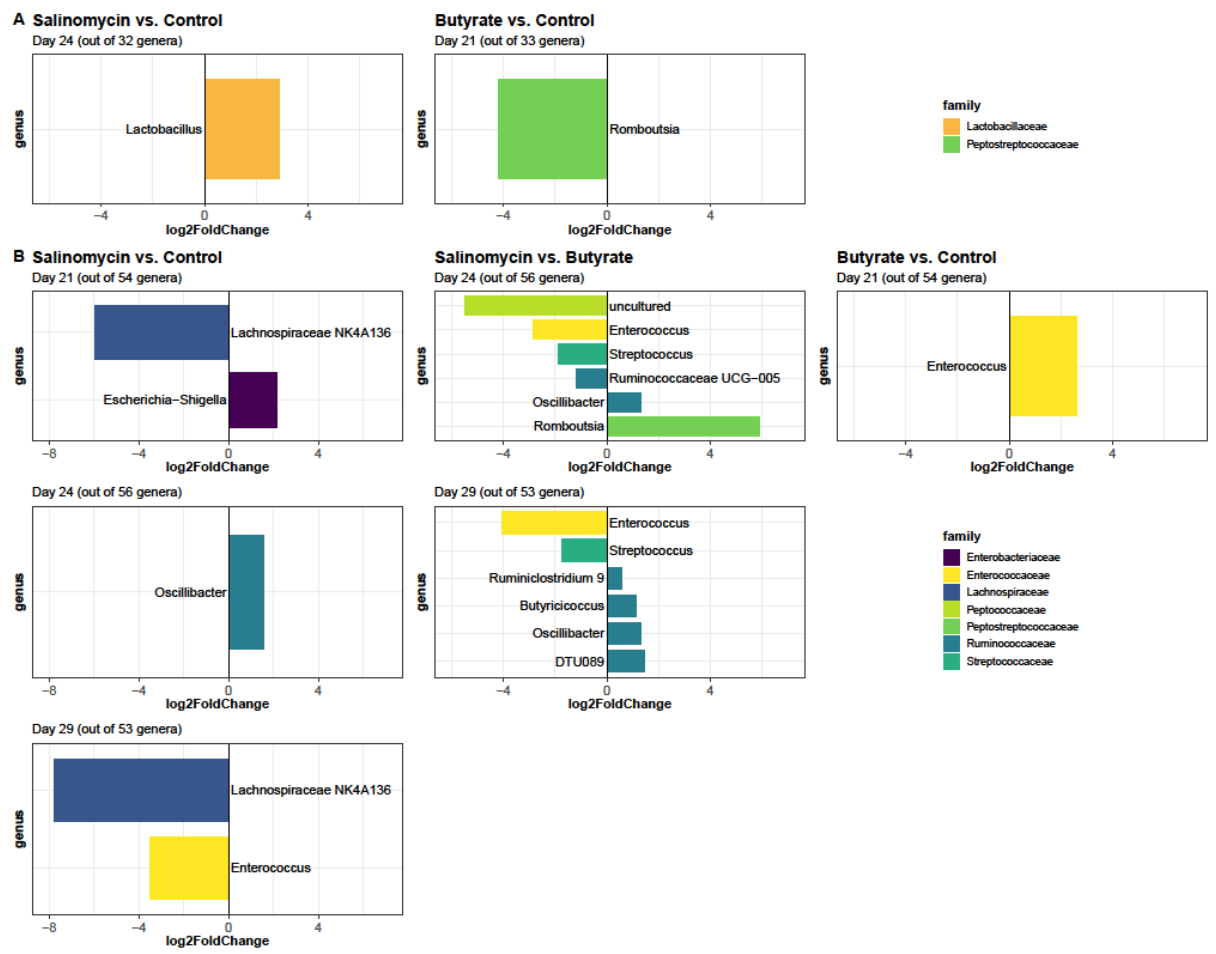
Figure 7. Differential abundance analysis at genus level for ( A ) ileum and ( B ) ceca samples between butyrate vs. control, salinomycin vs. control, and butyrate versus salinomycin (referred to as con- trasts). Contrasts were analyzed for each sampling day separately. A genus was define differentially expressed for Benjamini-Hochberg adjusted p values ≤ 0.05. Only significant results are shown. Information on contrasts, sampling day and total number of detected ASVs are defined in each figure title. A positive fold change means that the taxa abundance was higher in the first named treatment group compared to the second named treatment group (e.g., for the comparison butyrate versus control, taxa with positive fold changes are higher expressed in butyrate compared to control samples collected at the same day). A negative fold change means that the taxa abundance was lower in the first named treatment group compared to the second named treatment group. Color scale applied represents the family assignment of each differentially abundant